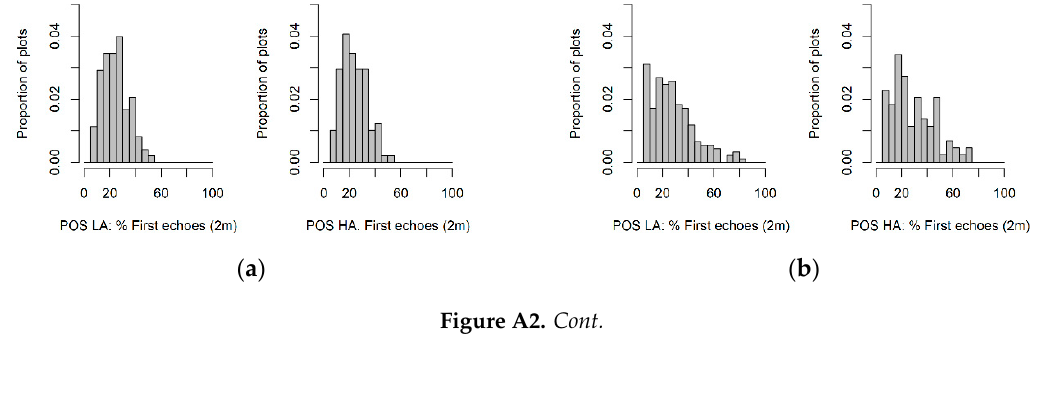
Figure A1. Histograms of the maximum height computed from all the ALS echoes inside the sample plots. The results are presented for low- and high-accuracy measurements and for the seven forest ecosystems assessed: Dehesa ( a ), Encinar ( b ), Pinaster ( c ), Eucalyptus ( d ), Pinea ( e ), Canario ( f ) and Fayal-Brezal ( g ).